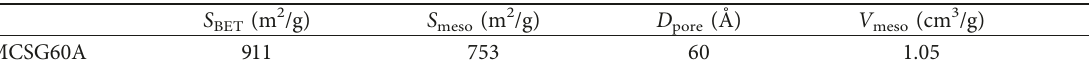
Figure 1: Cobalt adsorption kinetic on synthetized MCSG60A. Conditions: [Co 2+ ] and 1100rpm.